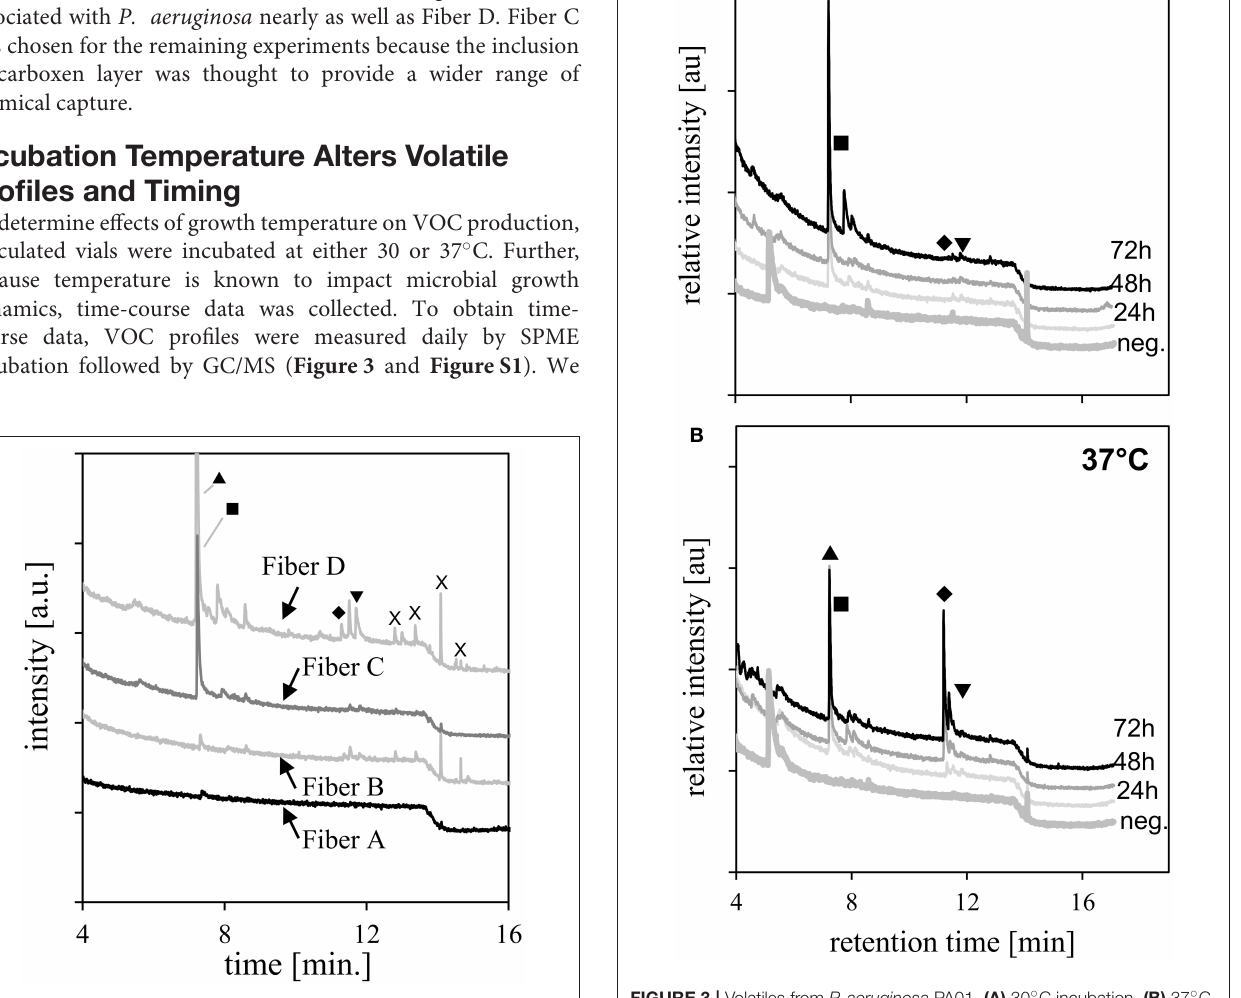
FIGURE 2 | GC/MS chromatograms of P. aeruginosa PAO1 cultures extracted with different SPME fiber types at 30 ◦ C for 24h. Peaks from P. aeruginosa PAO1 are designated by symbols: N = 1-undecene; (cid:4) = 2-nonanone; (cid:7) = 2-undecanone; H = 2-undecanol. Peaks labeled as X are identified as siloxane contaminants.